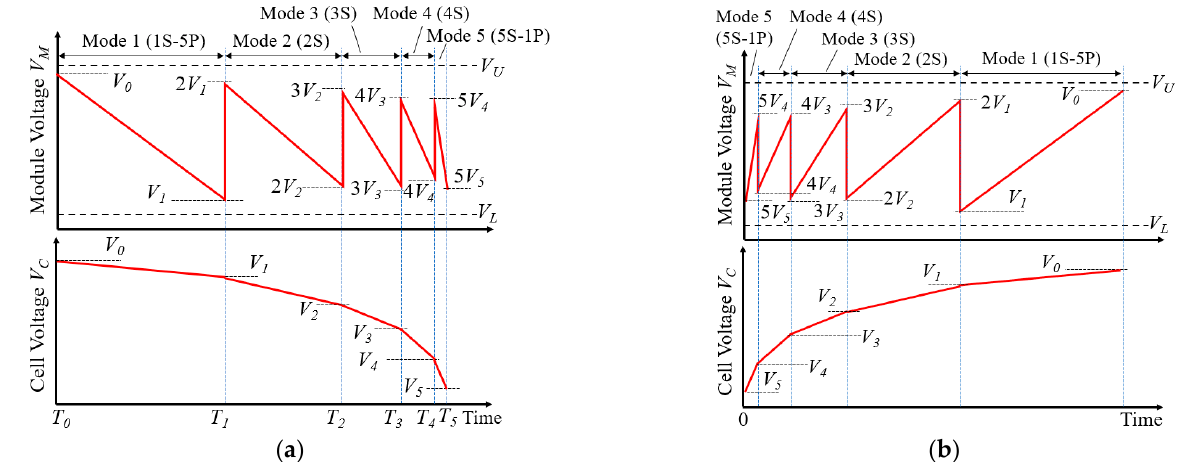
Figure 9. Module and cell voltage profiles in ( a ) discharging and ( b ) charging processes.